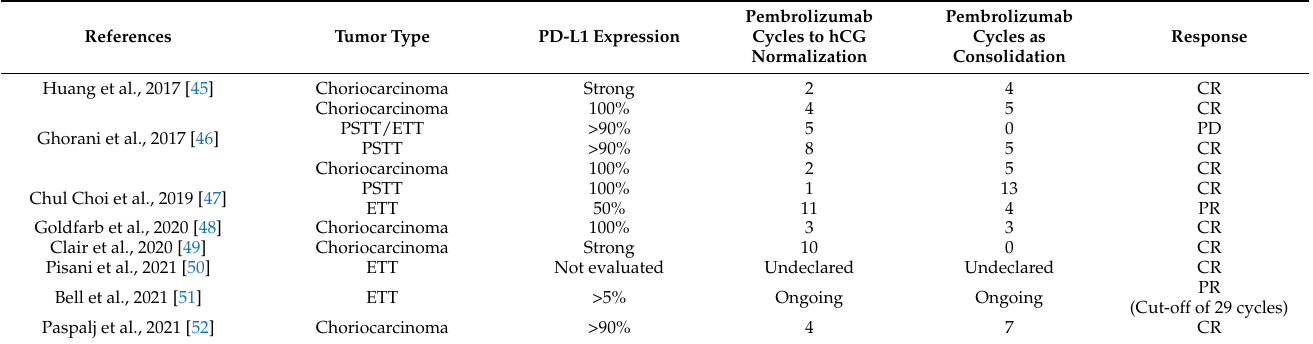
Table 3. Review of GTN cases treated with Pembrolizumab reported in the literature (PD— progression of disease, CR—complete response, PR—partial